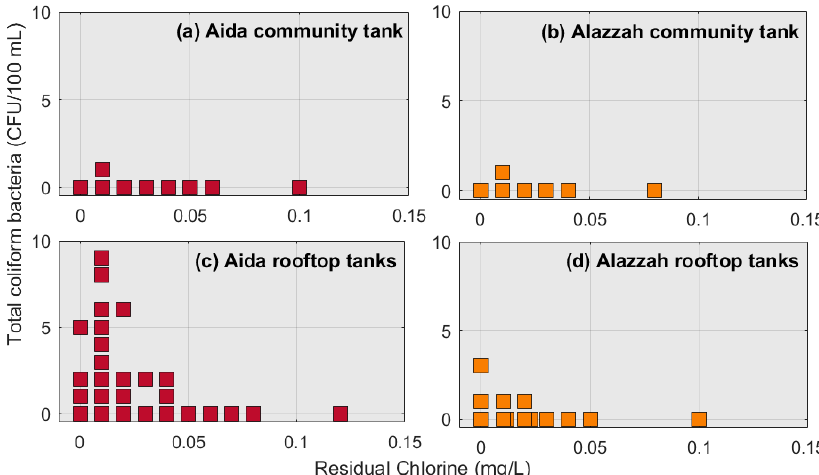
Figure 5. Relationship between bacteria levels (CFU concentrations) and residual free chlorine concentrations in ( a ) and ( b ) community- and ( c ) and ( d ) rooftop-tank water samples from Aida Camp and Alazzah Camp. See Figure A1, Figure 2A and Table A1 for regression statistics.